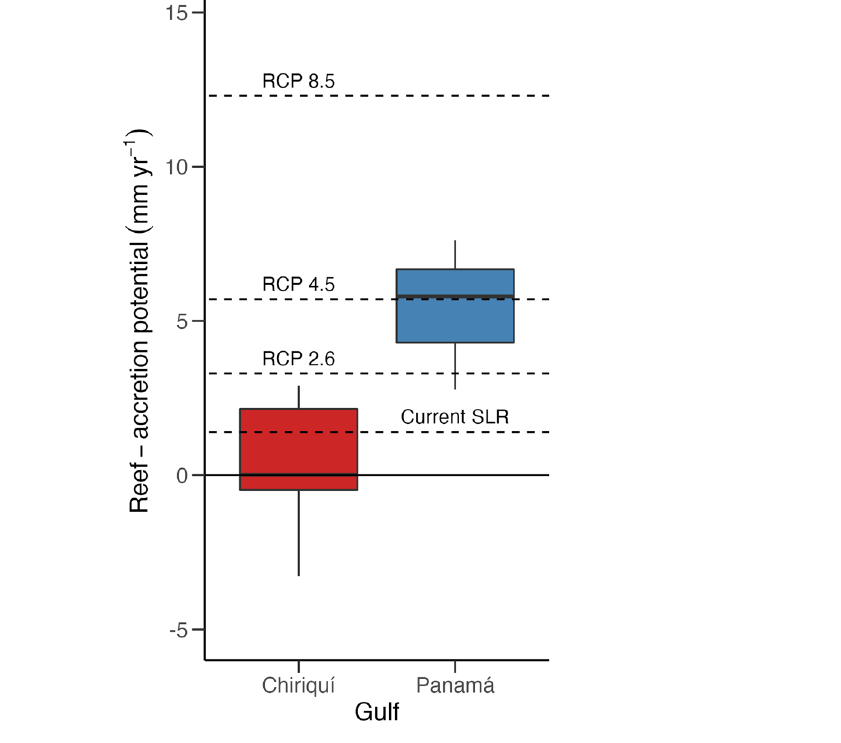
Figure 4. Boxplot of median (± interquartile range) reef-accretion potential (mm year −1 ) for each gulf during the most recent survey (spring 2018). The horizontal lines represent the projected mean sea-level rise for each of three RCPs 12 , as well as the current rate of sea-level rise for Panamá 74 . The black horizontal line delimits the division between net accretion and net